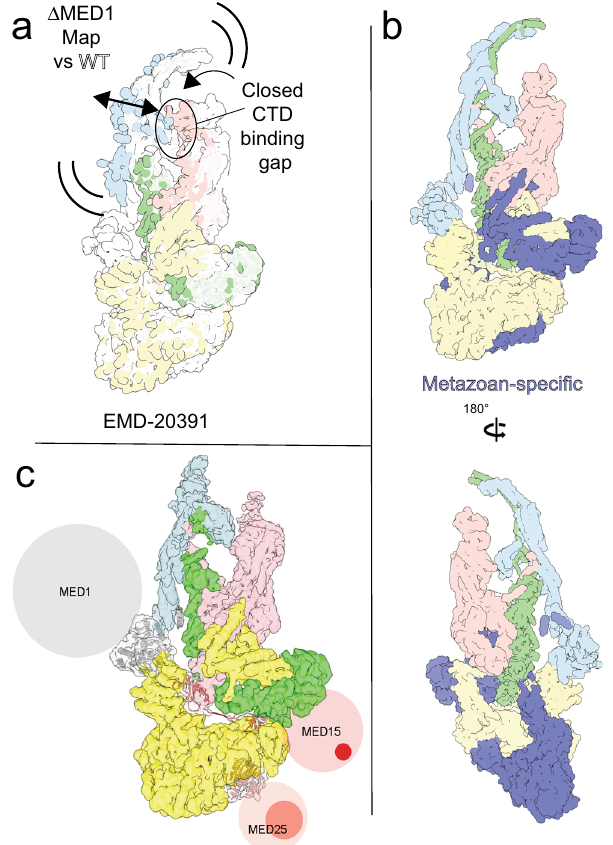
Fig. 7 Tail and Mediator – RNAPII interactions. a Cryo-EM analysis of Δ MED1 mMED (EMDB EMD-20391) showed conformational rearrangements of the Middle and Head that closed the CTD-binding gap, consistent with observed RNAPII interaction. b Metazoan-speci fi c subunits and subunit domains in mMED contribute to an intricate and very extended Tail – core interaction. c Mediator subunits targeted by TFs include large IDRs and at least some of the sites speci fi cally targeted by TFs are included in those IDRs, bringing up the question of how TF binding could trigger Mediator conformational